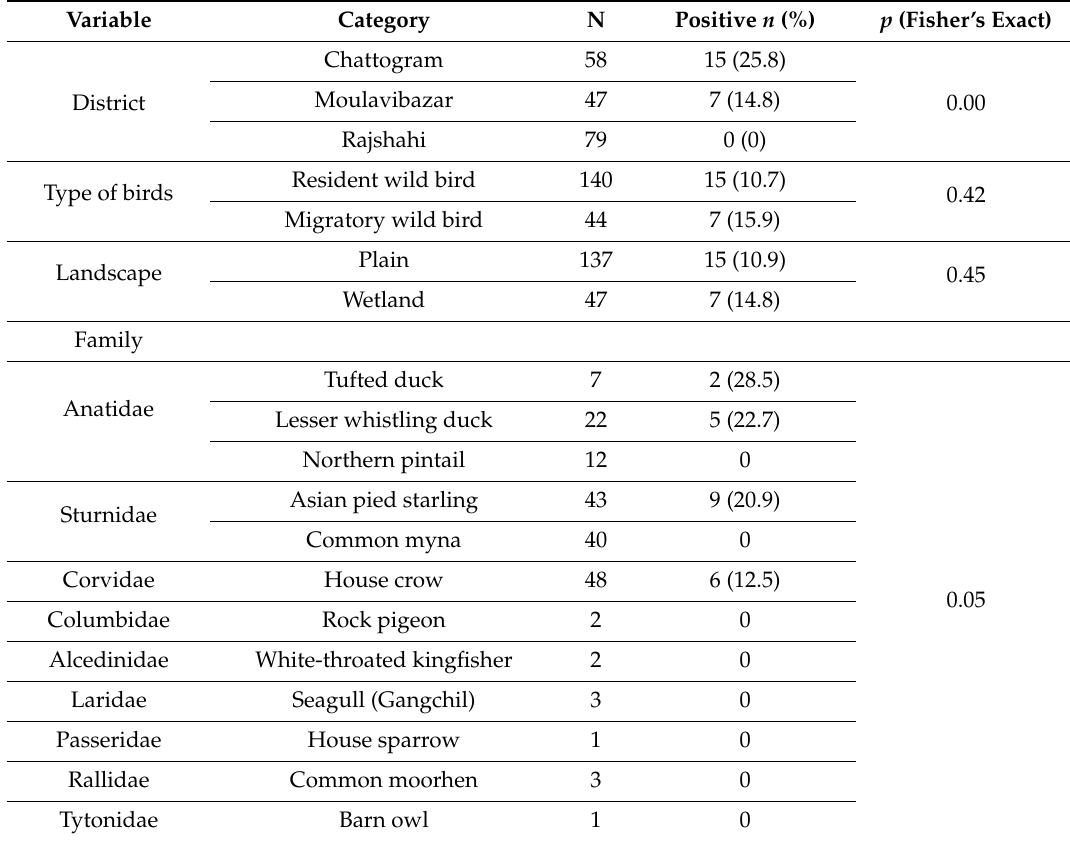
Table 1. Univariate association between West Nile Virus seroprevalence and selected factors (N =